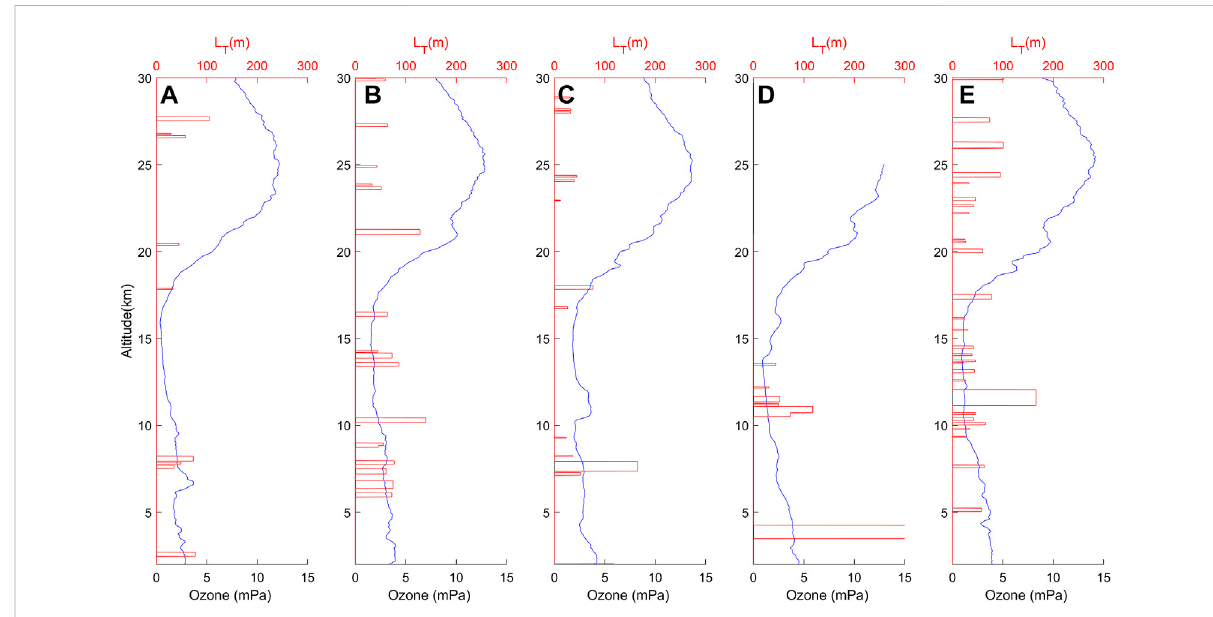
FIGURE 6 Distributions of the ozone partial pressure and Thorpe scale: panels (A) – (E) represent the data collected from October 15 to 21,